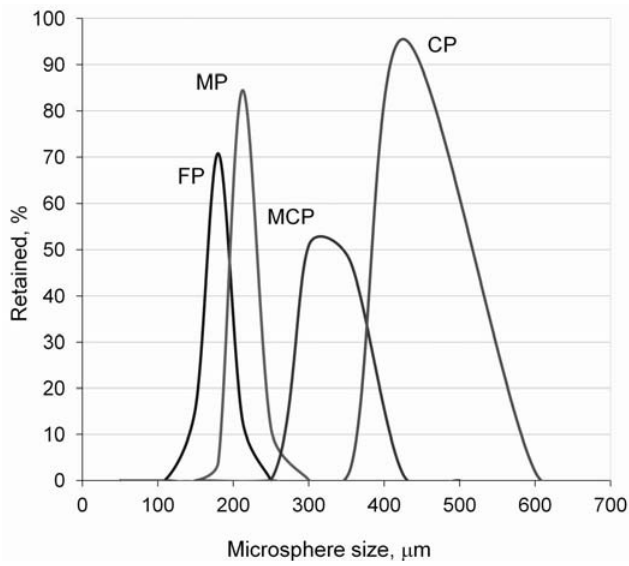
Figure 2. Particle size distribution of the Ti–6Al–4V microspheres.